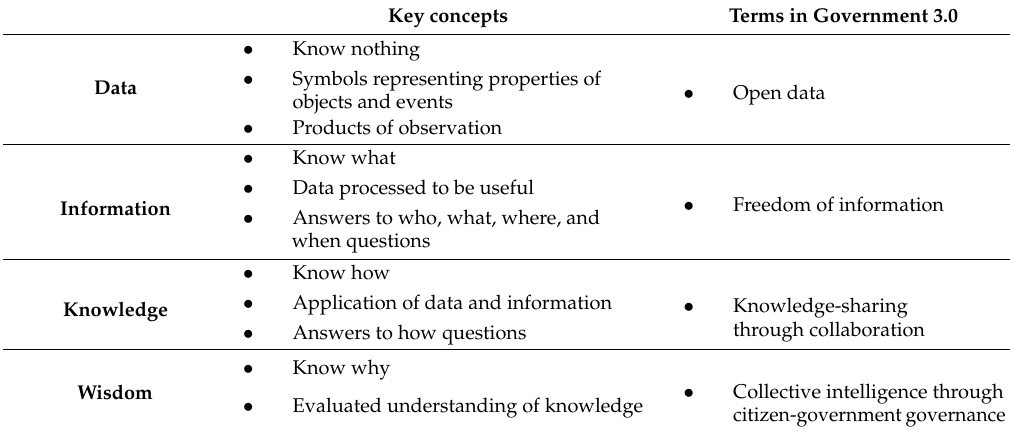
Table 3. The conceptual hierarchy of data, information, knowledge, and wisdom. (Source: Ackoff [32], Rowley [33], and Zeleny